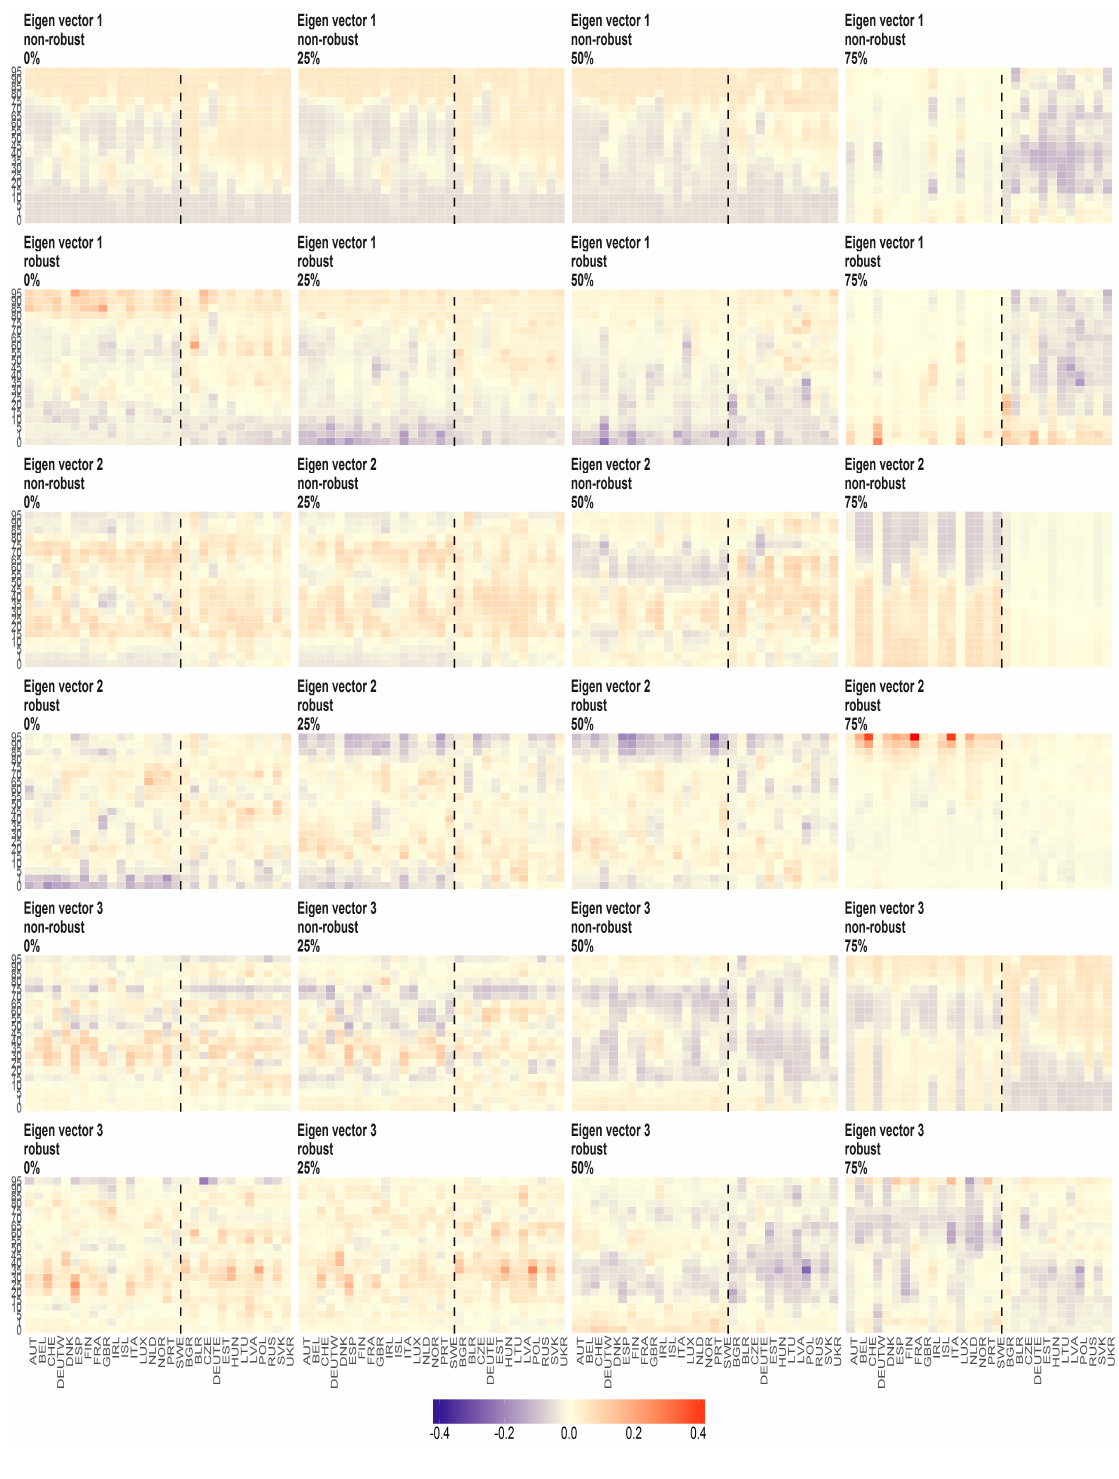
Figure 20. The eigenvectors of Death counts (y axis) over age groups (y axis) and countries (x axis) obtained using PPCA for Males . Every row of subfigure corresponds to different eigenvector. Every column corresponds to different level of maximum missing values per observation (0%, 25%, 50% and 75%). The blue line corresponds to robust standardisation whereas red line to non-robust standardisation of